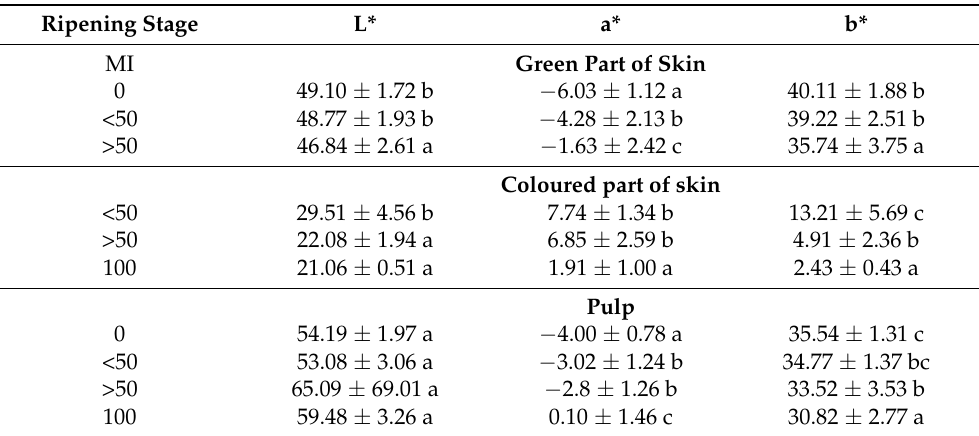
Table 2. Color parameters of the green and colored parts of skin and pulp of olive fruits at different ripening